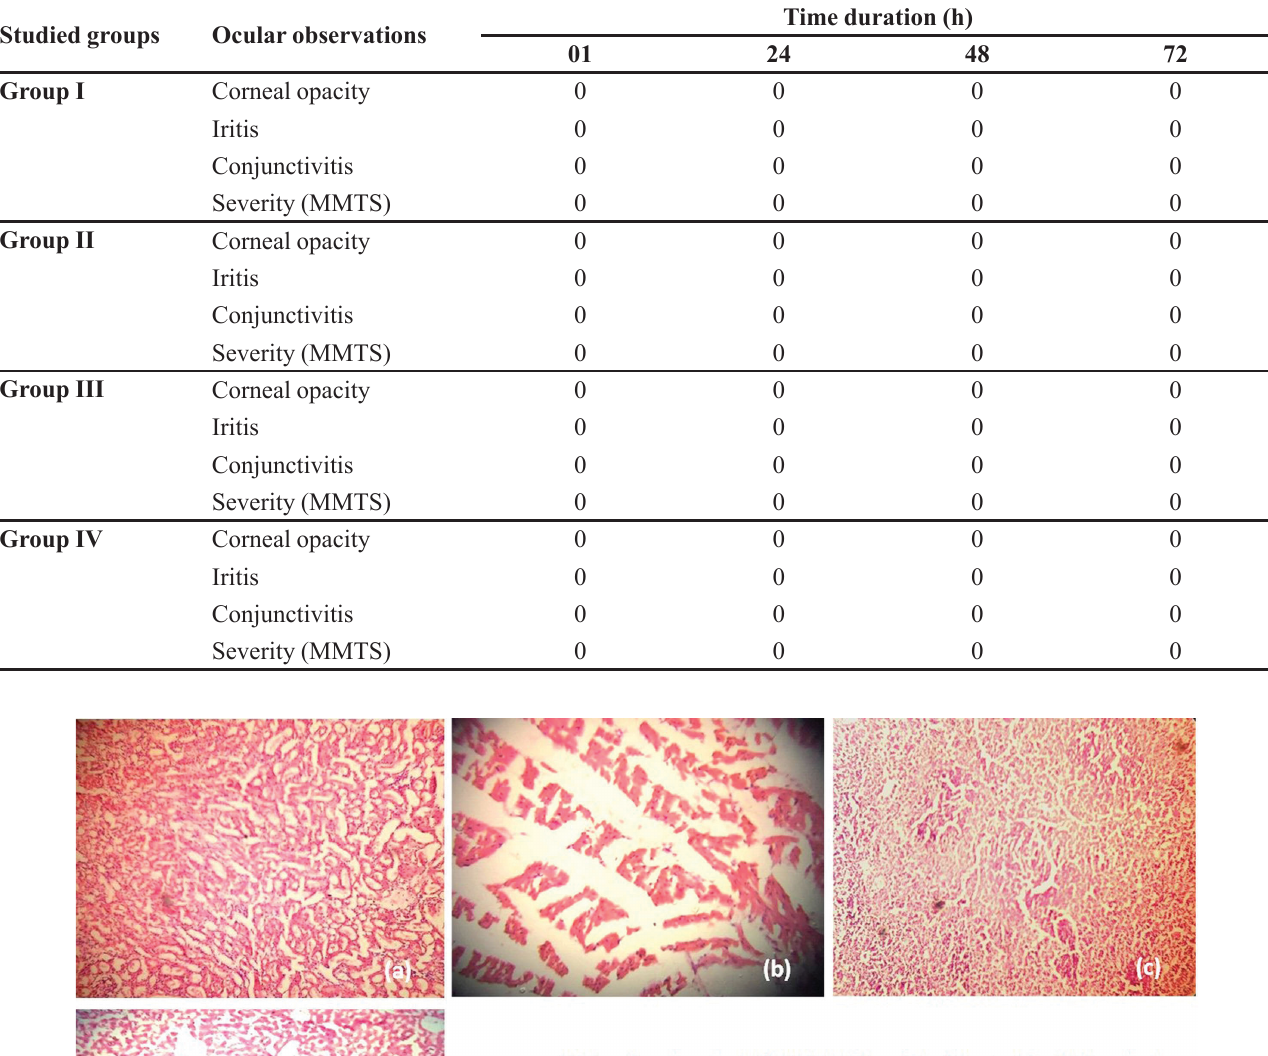
TABLE II - Scores calculated using Kay and Calandra eye irritation scale Studied groups